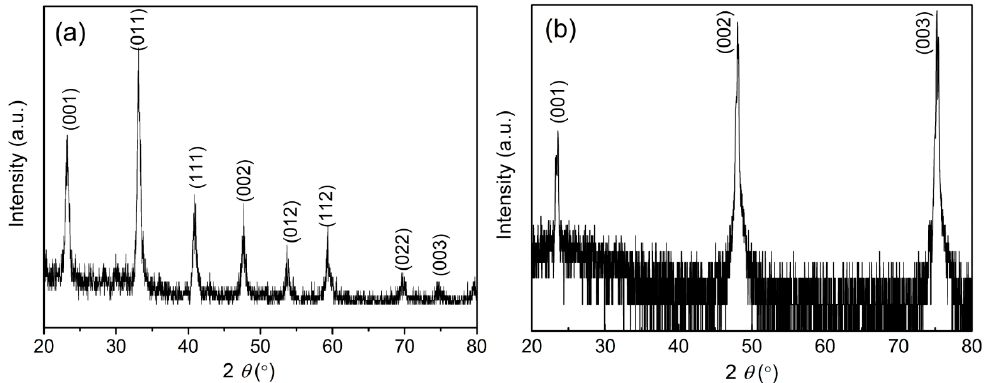
Figure 2. XRD patterns of LaAlO 3 (LAO) films grown on Si ( a ) and LAO ( b ) substrates.